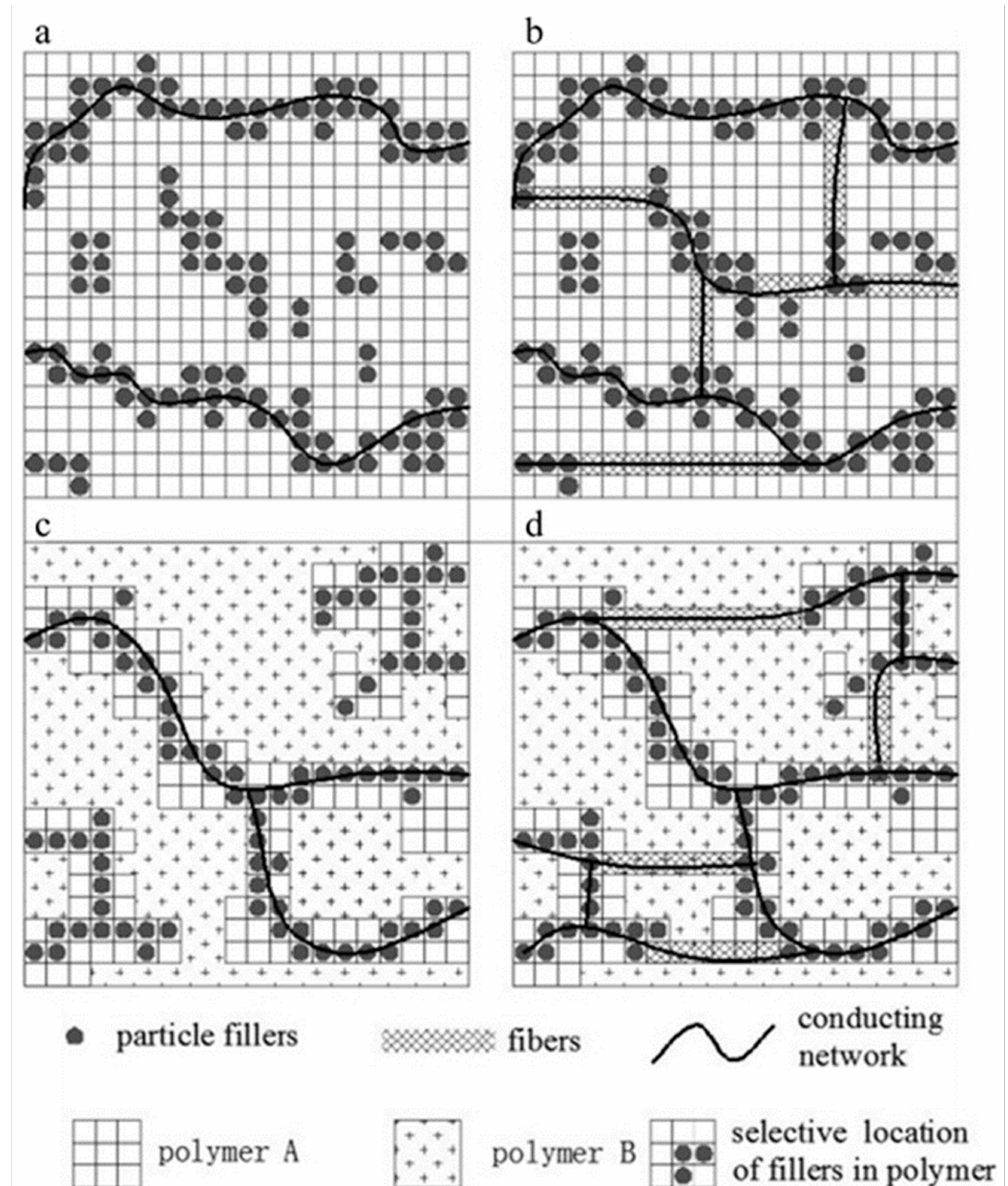
Figure 6. Schematic representation of microstructures and possible conductive paths for conduc- tive polymer composites: ( a ) single filler (either spherical particles or fibers) dispersed into a single polymer matrix, ( b ) dual fillers (both spherical particles and fibers) dispersed into a sin- gle polymer matrix, ( c ) single filler (either spherical particles or fibers) dispersed into a blend of two immiscible polymers, and ( d ) dual fillers (both spherical particles and fibers) dispersed into a blend of two immiscible polymers. Reprinted with permission from